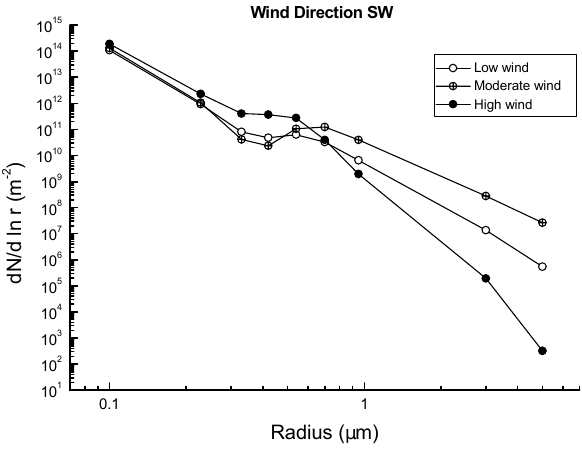
Fig. 10. Same as Fig. 9 for southwest wind